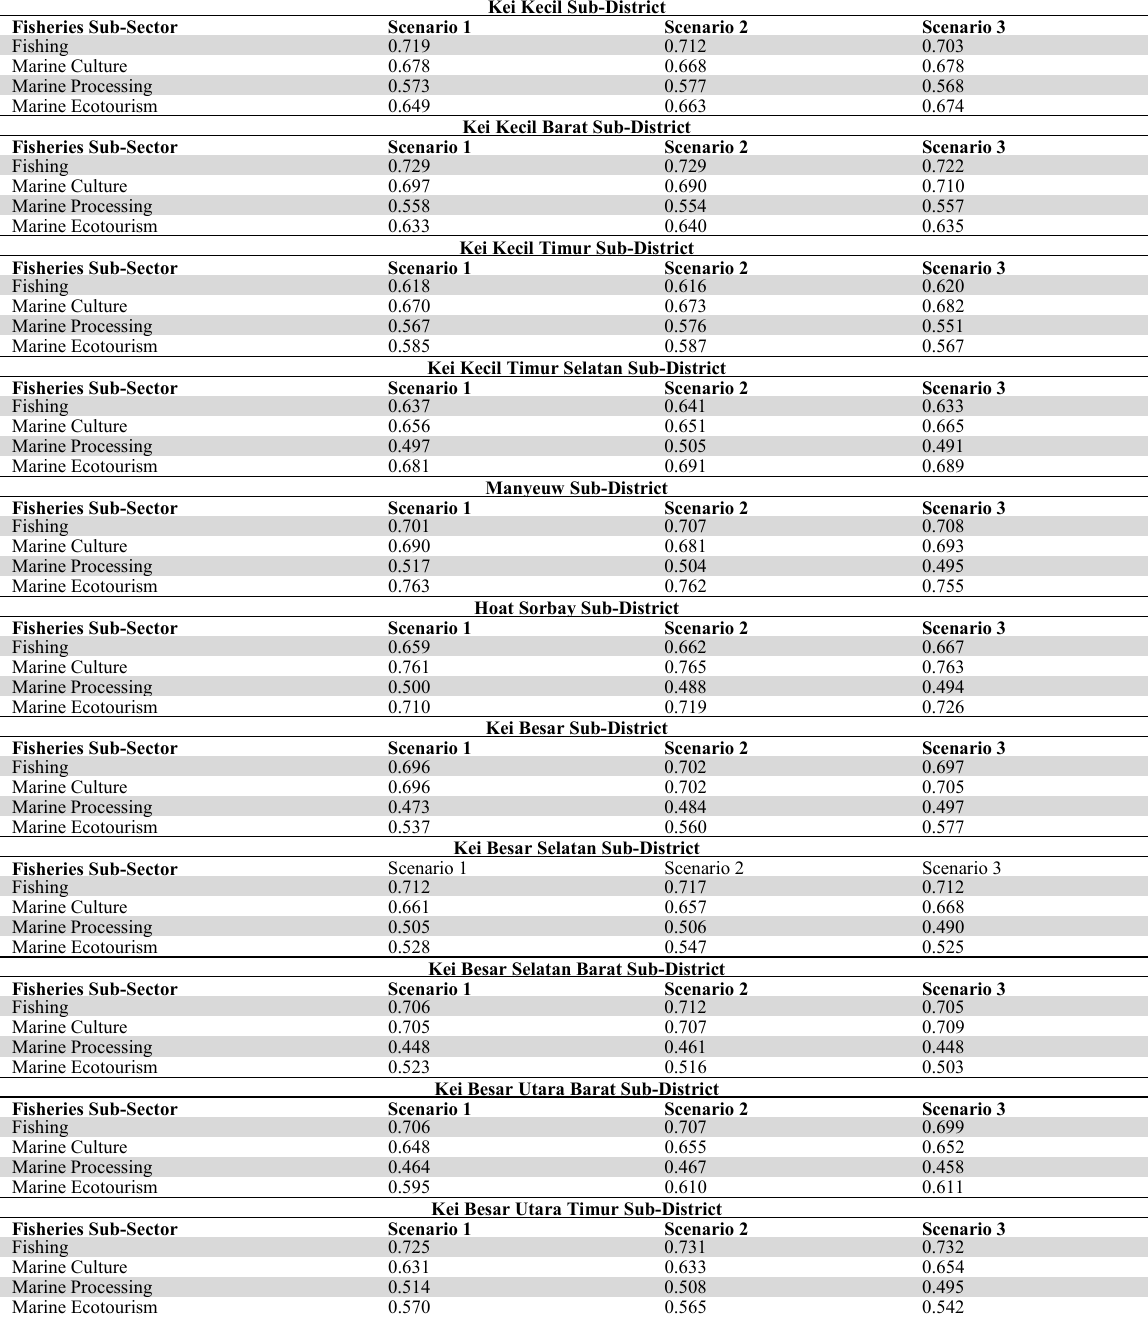
Table 23 Sensitivity